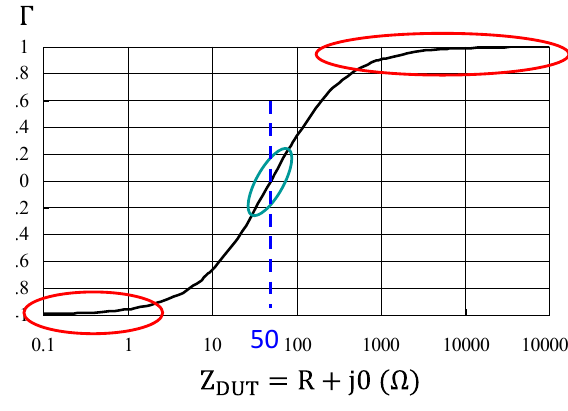
Figure 1: Reflection coefficient Γ as a function of a real impedance 𝑍 DUT